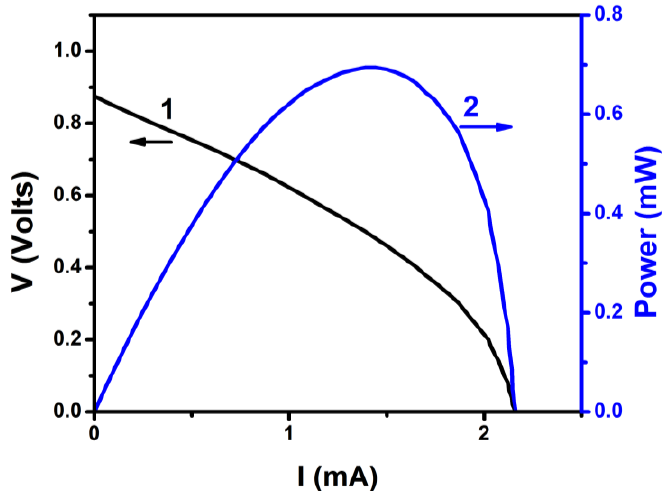
Figure 5. Current-voltage and power curve for a VRB directly charged by connection to the PFC.